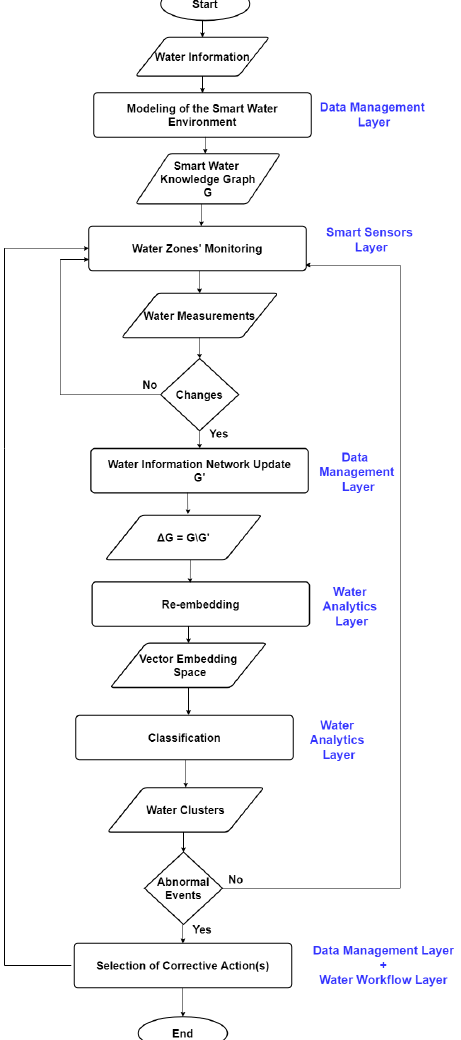
Figure 2. System workflow of the smart water management